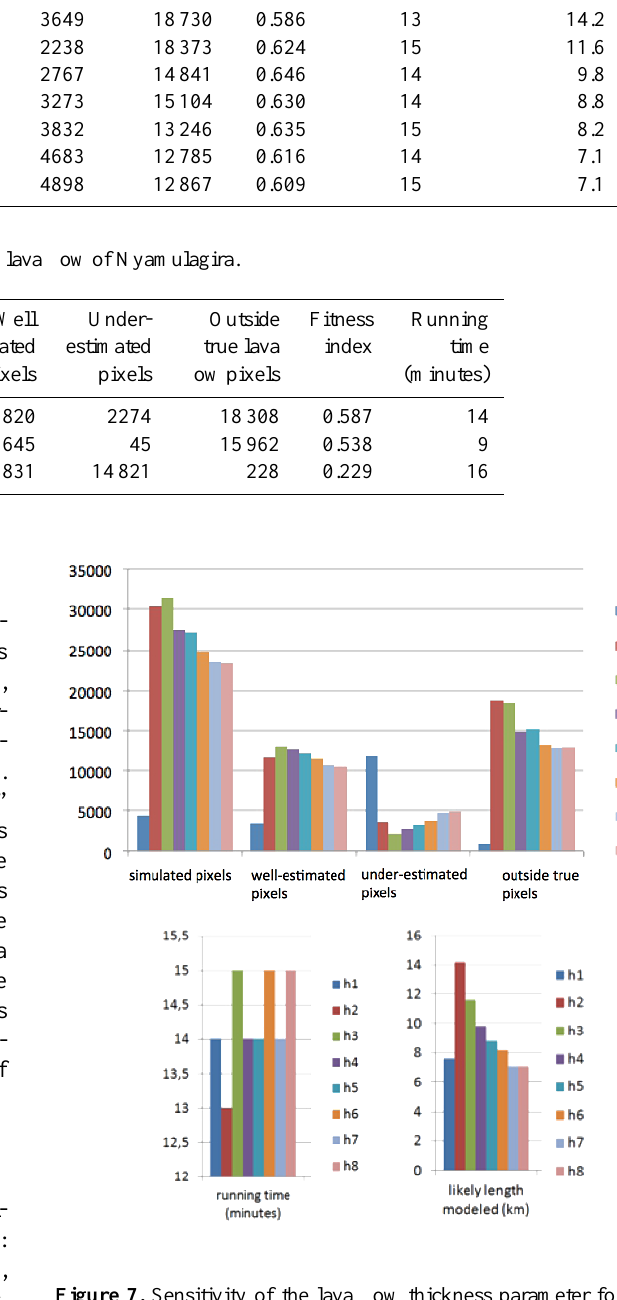
Figure 7. Sensitivity of the lava flow thickness parameter for the simulation of the 2010 lava flow of Nyamulagira (h1–h8, simula- tions of 1, 2, 3, 4, 5, 6, 7 and 8m of lava-flow thickness, respec-